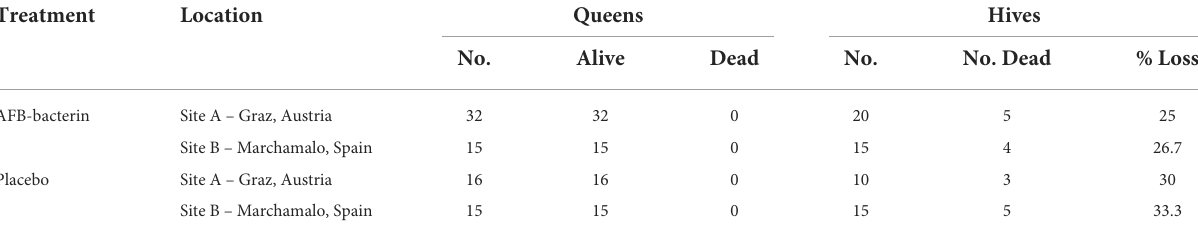
TABLE 1 The survival of the queens during vaccination. Treatment